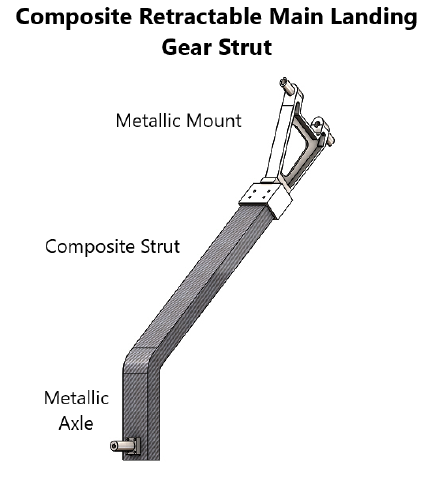
Figure 8. CAD Model of a retractable main landing gear